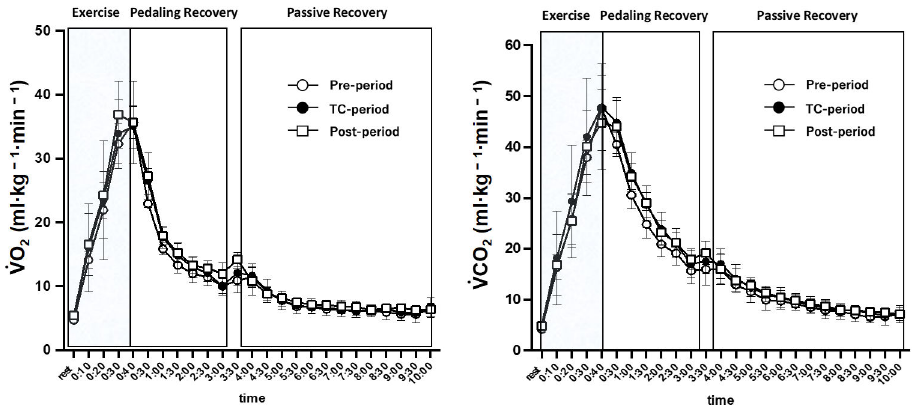
Figure 5. VO 2 (ml · kg − 1 · min − 1 ) and VCO 2 (ml · kg − 1 · min − 1 ) during and after the 40 s Wingate test in each period. The values are expressed as means ± SD.